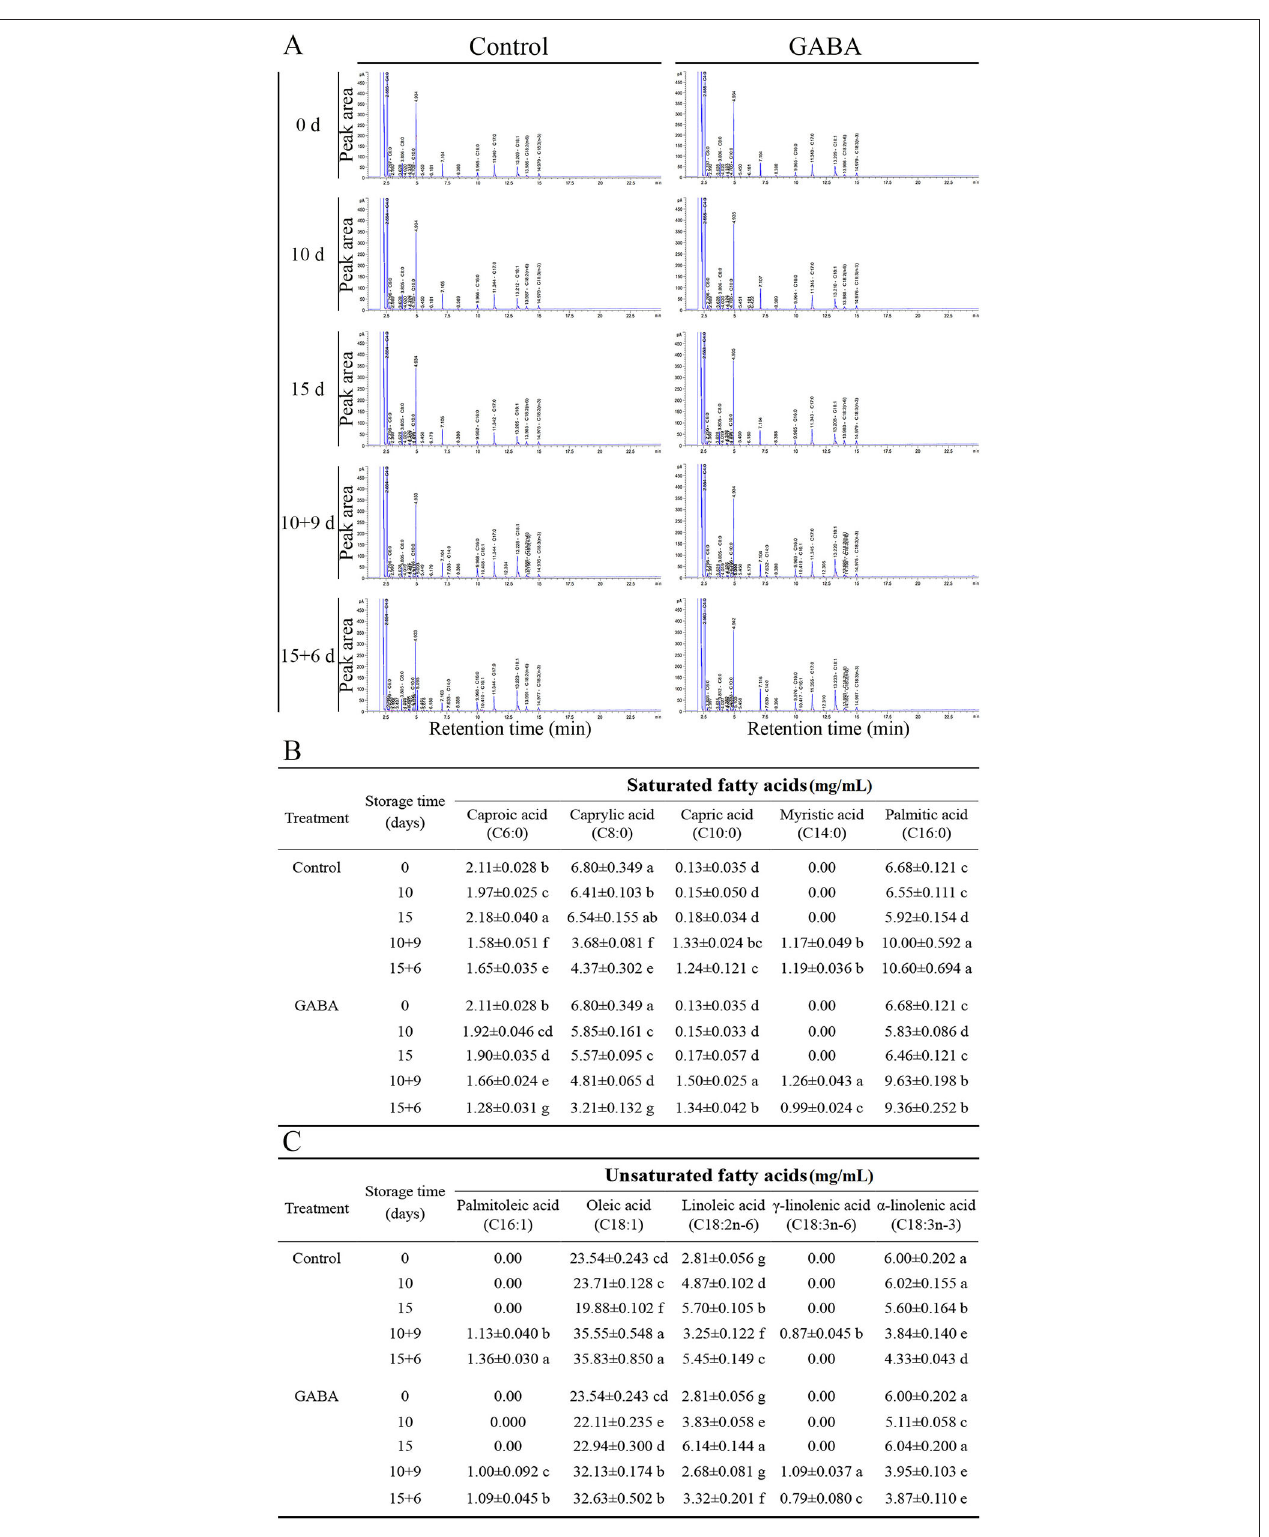
FIGURE 8 | The peak area of fatty acids composition of carambola fruit during storage at 4 and 25 ◦ C (A) , saturated fatty acids (B), and unsaturated fatty acids (C) . Data are means ± SD (standard deviation) of three replicates ( n = 3).